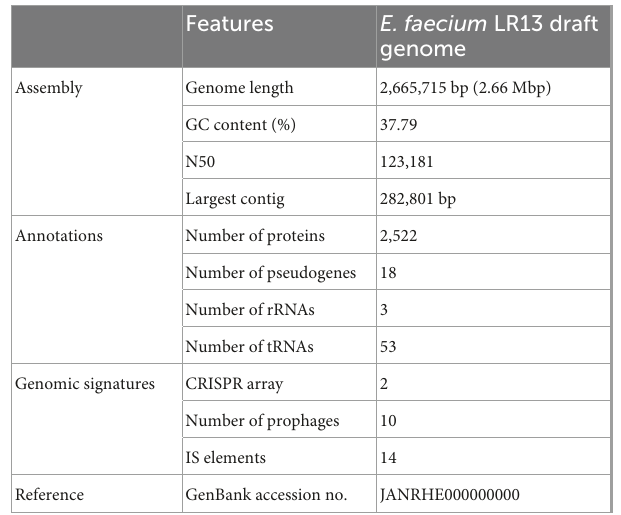
TABLE 1 Genomic features of E. faecium